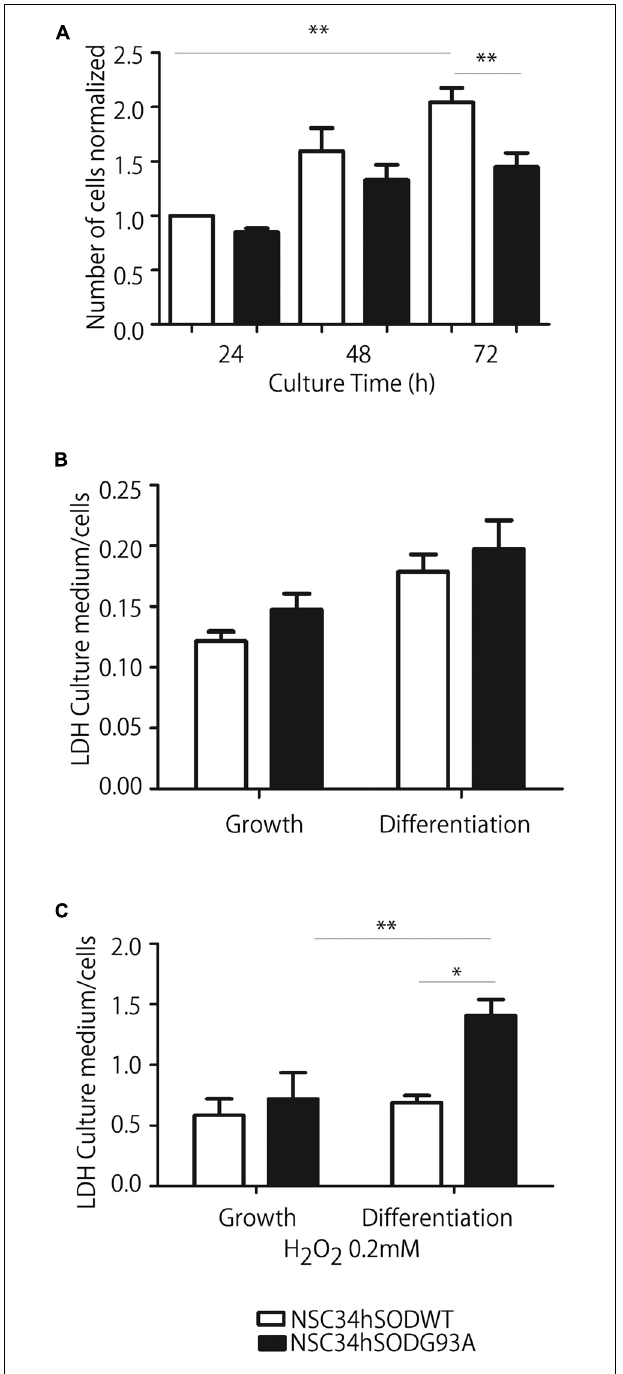
FIGURE 2 | NSC34-hSOD1G93A cells proliferate less efficiently and are more susceptible to oxidation-induced cell death. (A) Cells were seeded in p35 plastic dishes and kept in growing medium for up to 72 h. Cells were tripsinized every 24 h and counted. Plot represents the average ± SEM of three independent experiments performed by triplicate ( ∗∗ p < 0.001, ANOVA). (B,C) NSC34-hSOD1 cells were seeded in PLL/gelatin-coated plastic dishes and differentiated (B) or treated with H2O2 and differentiated (C) . Plots represent the ratio of LDH concentration in conditioned media against that in cell extracts, and is the average ± SEM of three experiments ( ∗ p < 0.05,